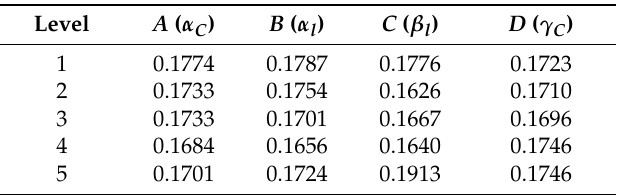
Table 6. Mean values calculation results.